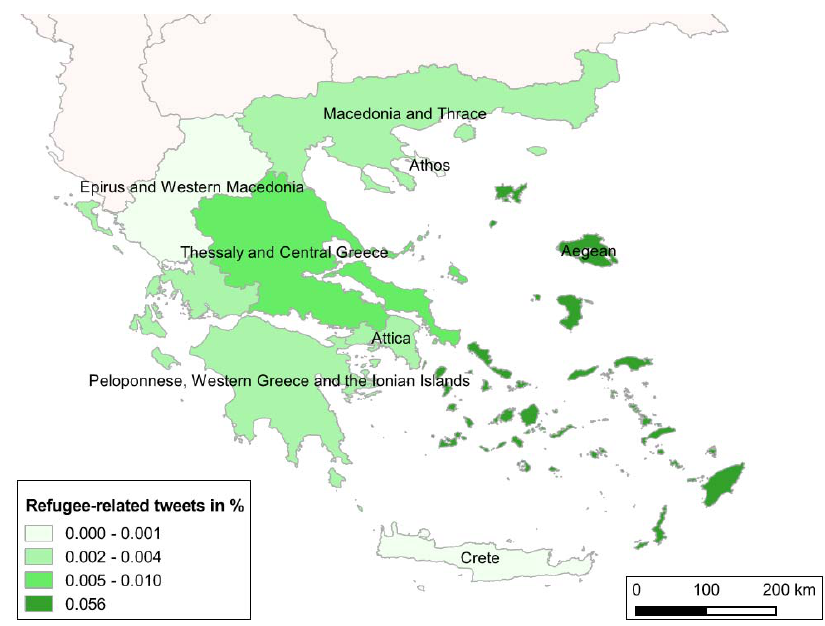
Figure 15. Percentage of refugee related tweets in decentralized public authorities for Greece.